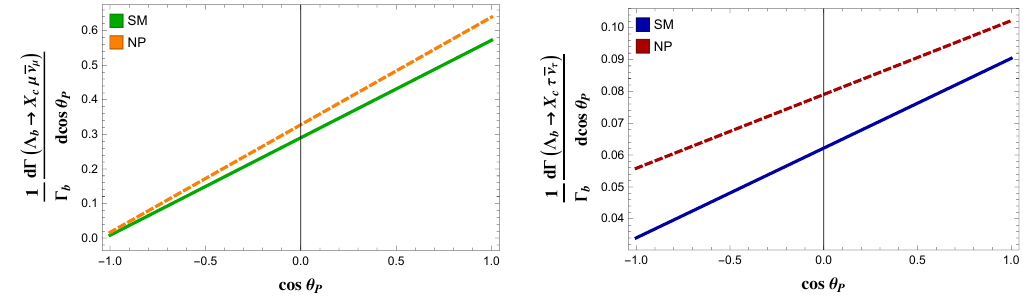
d (cid:0) Figure 5 . 1 distribution for (cid:3) b ! X c ‘ (cid:22) (cid:23) ‘ , with ‘ = (cid:22) (left) and ‘ = (cid:28) (right). The solid (cid:0) b d cos (cid:18) P line is the SM result, the dashed line the NP result at the benchmark point.